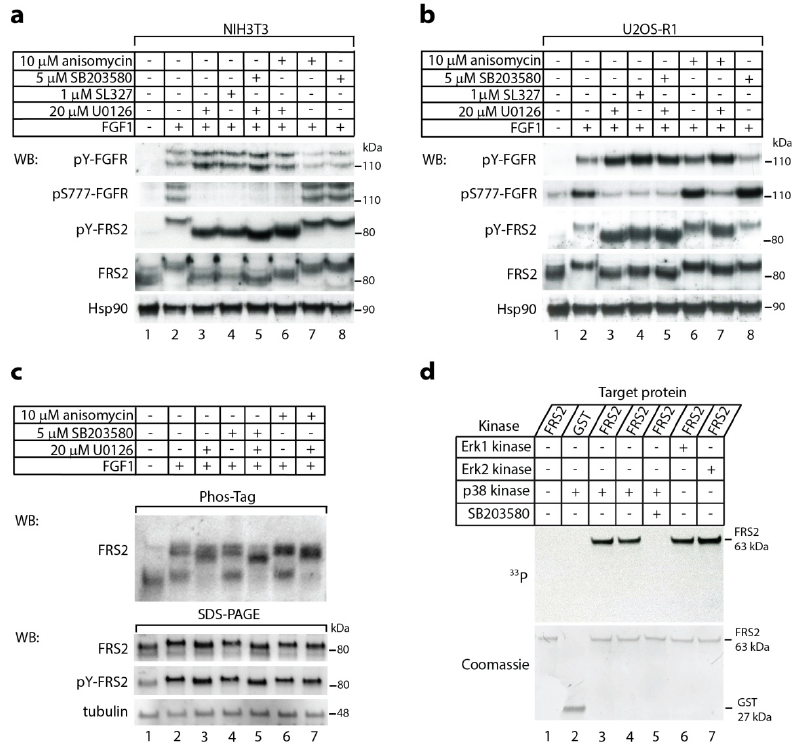
Figure 1. The effect of p38 activity on FRS2. ( a – c ) FGF1-induced electrophoretic mobility shift of FRS2. Serum-starved ( a , c ) NIH3T3 and ( b ) U2OS-R1 were pretreated for 20 min with or without MEK1 / 2 inhibitors (20 µ M U0126, 1 µ M SL327), p38 inhibitor (5 µ M SB203580), and p38 activator (10 µ